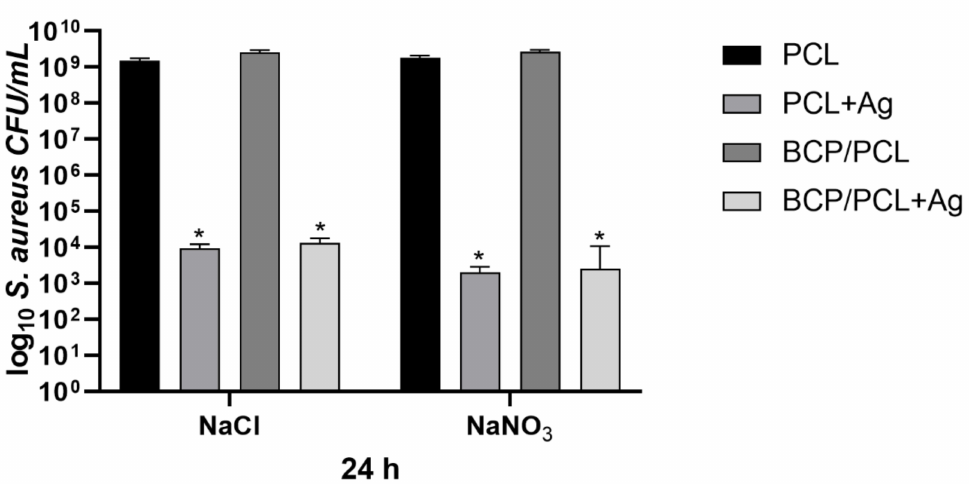
Figure 6. Number of adherent staphylococci (log 10 colony forming units, CFU/mL) on the scaffolds, produced with either NaCl and NaNO 3 salts, after 24 h of incubation. Results are the mean values ± standard error of the mean (SEM) of at least three independent experiments. * p < 0.0001 unpaired t -test.